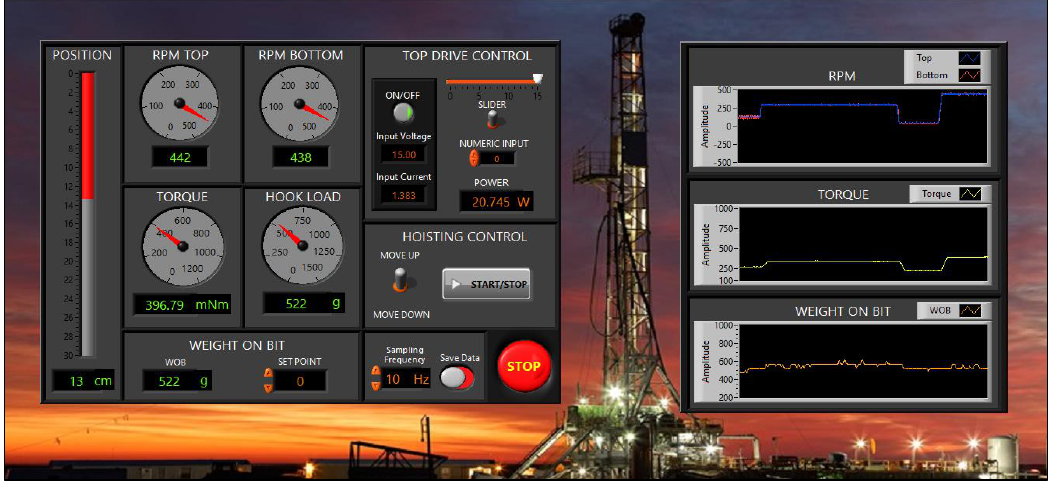
Figure 15. Human-machine